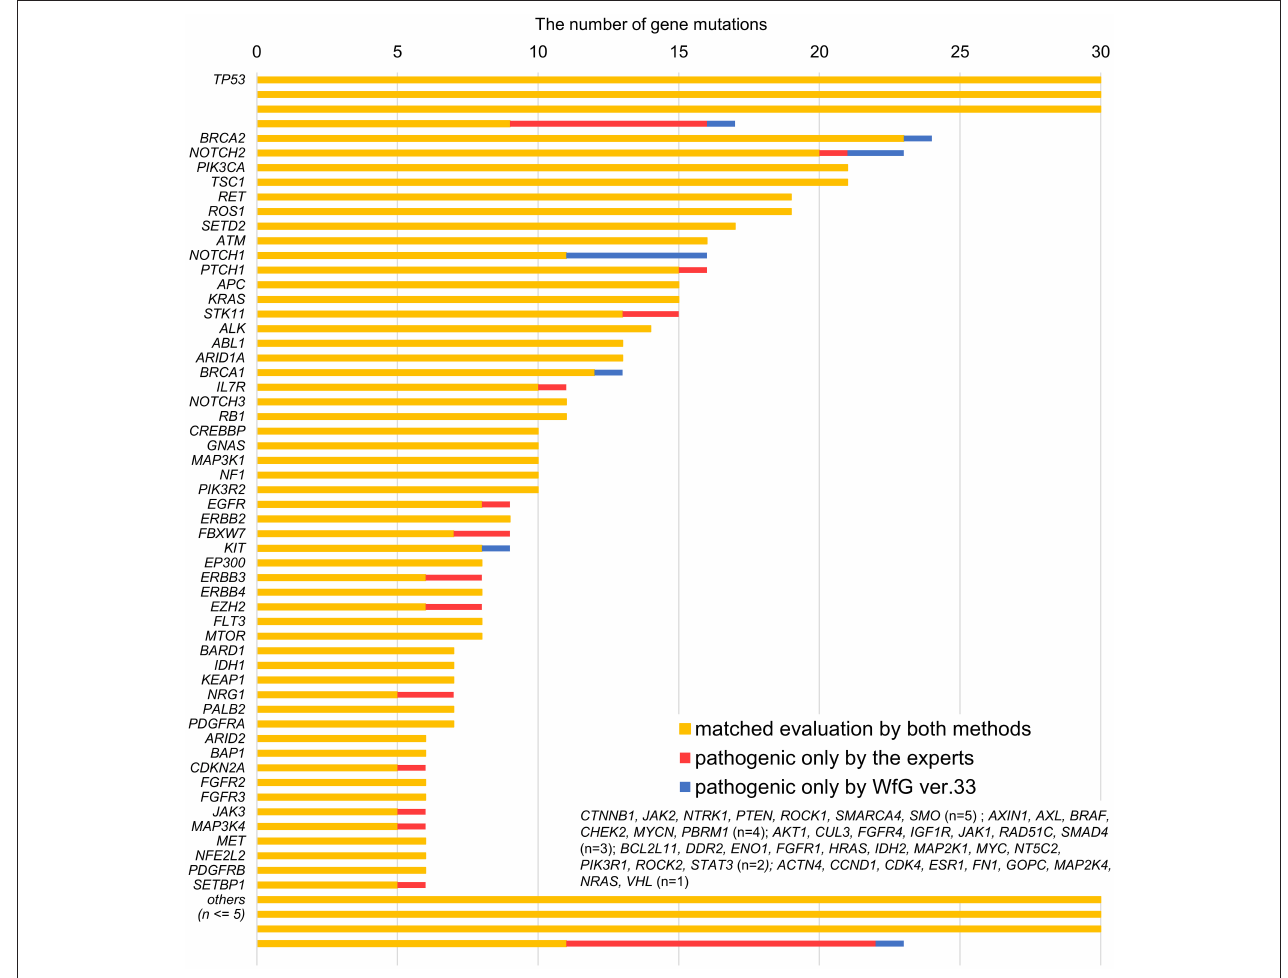
FIGURE 6 | Most recent concordance results for gene mutation pathogenicity between the expert panel and WfG ver. 33 by